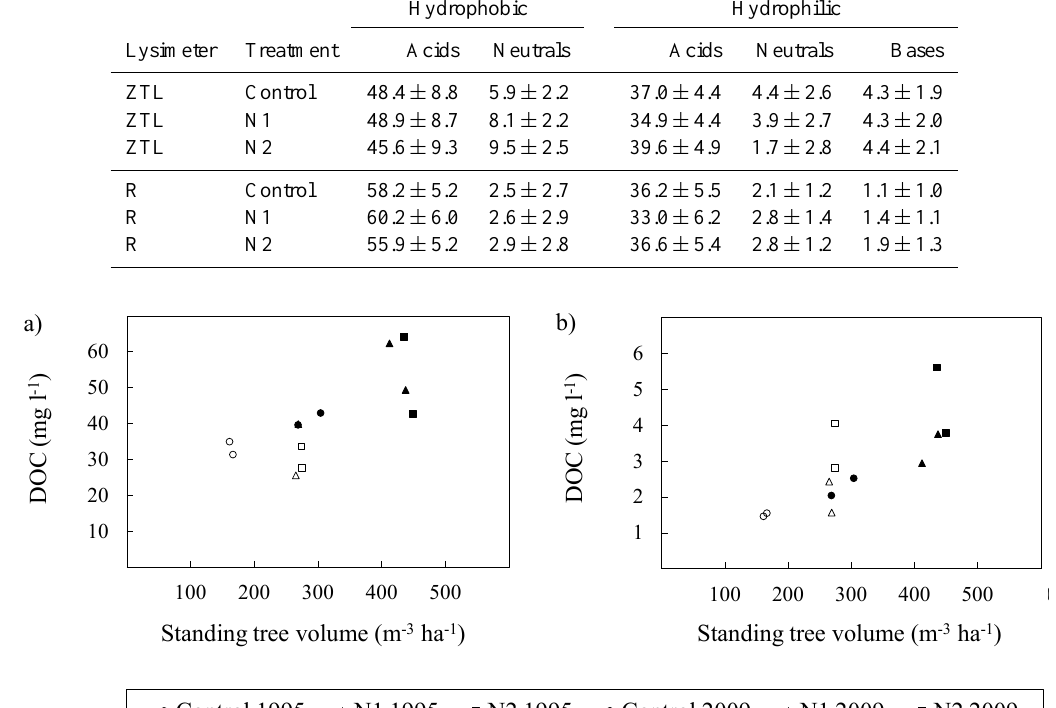
Fig. 2. Annual means of dissolved organic carbon, DOC, concentration (mgL − 1 ) in O horizon ZTLs (a) and mineral B horizon TLs (b) , and standing tree volume (m 3 ha − 1 ) at Str˚asan. Standing tree volume was determined in 1997 and 2010.